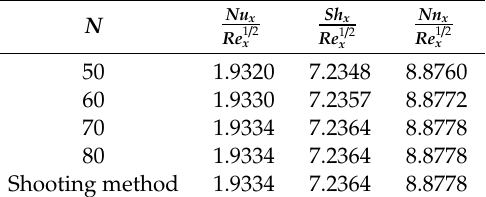
Table 3. Comparison of the present method with shooting technique.